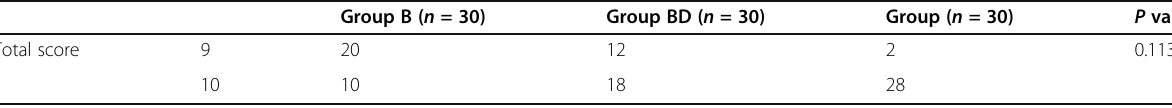
Table 2 Comparison of PADS in group B, group BD, and group